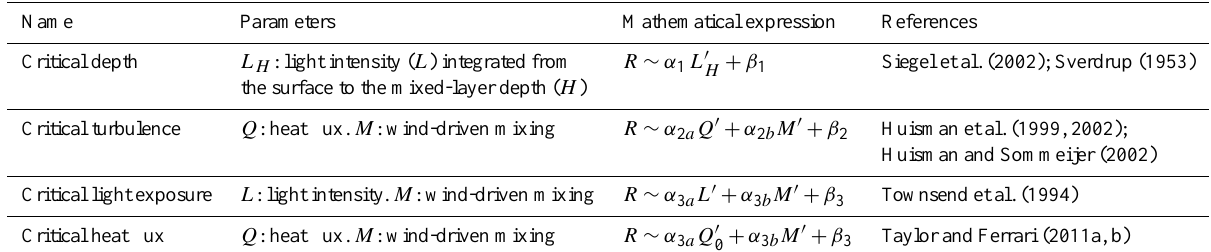
Table 1. Models to explain the rate of change phenology anomaly ( R ) were built based on published theories regarding the bloom onset. These are indicators of physical processes observed in the North